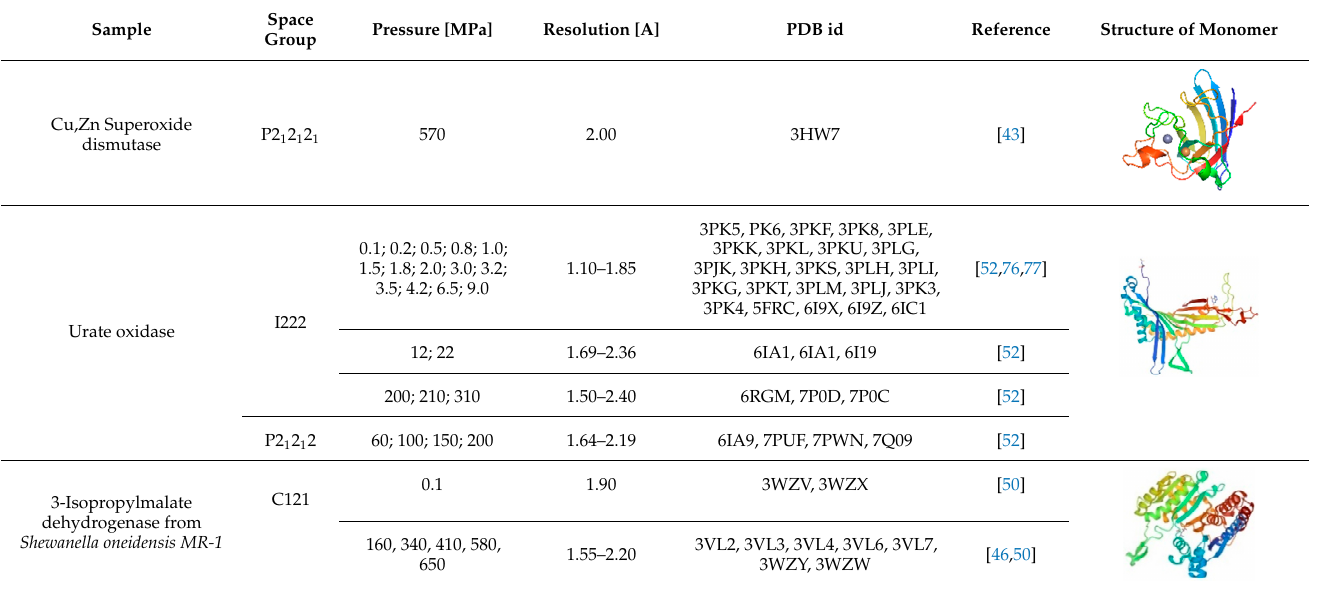
to illustrate the progress in the fi eld. Table 1. High pressure crystal structures of macromolecules deposited to PDB after Table 1. High pressure crystal structures of macromolecules deposited to PDB after 2010. Table 1. High pressure crystal structures of macromolecules deposited to PDB after 2010. Table 1. High pressure crystal structures of macromolecules deposited to PDB after 2010.